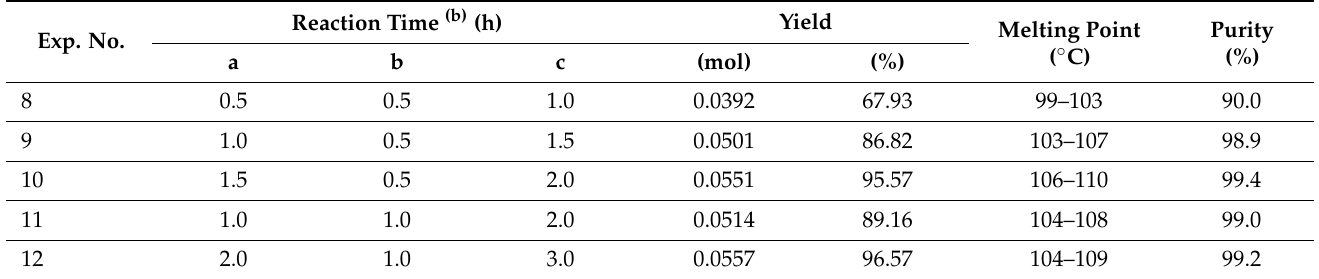
Table 2. The yield of TMTS as a function of reaction time (a)